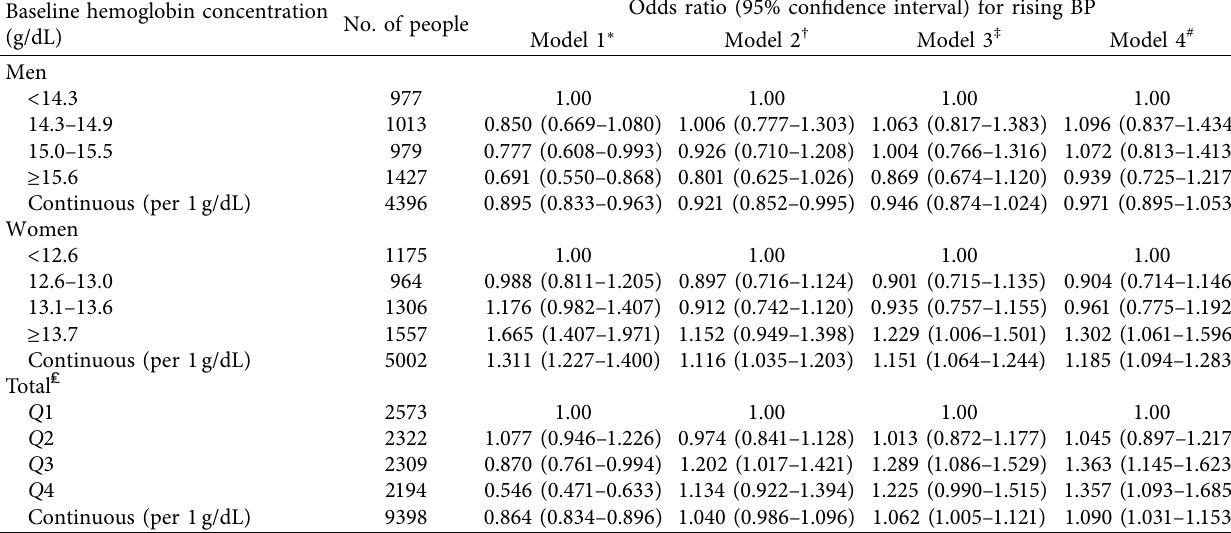
Table 3: Cross-sectional association between hemoglobin concentrations and HTN at baseline.